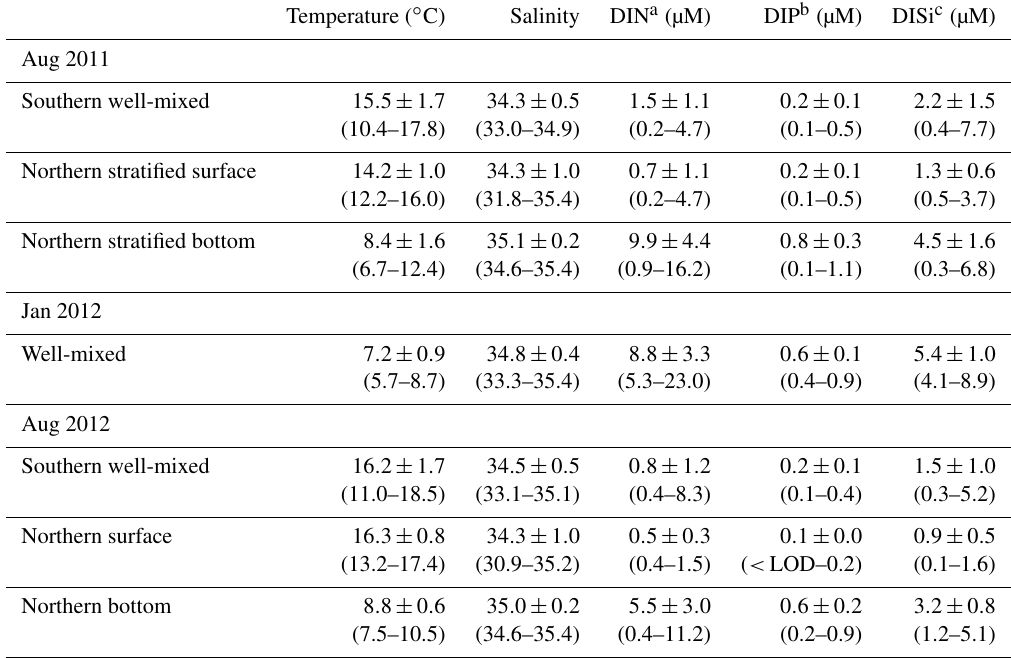
Table 2. Summary of physical and inorganic nutrient parameters during this